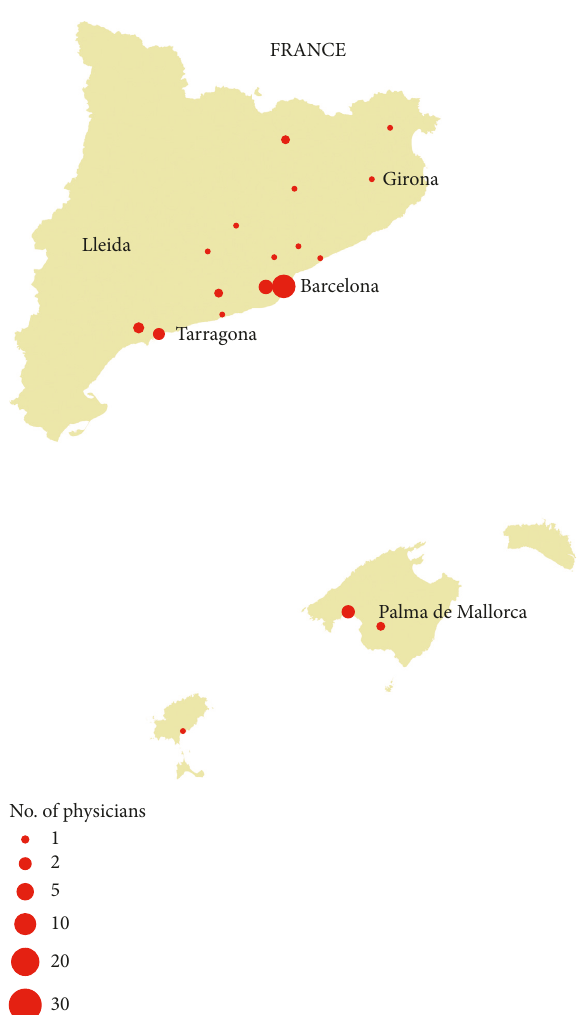
Figure 1: Display of the number of surveyed physicians per